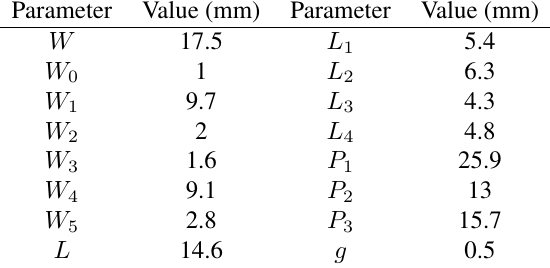
Table 1: Dimensions of the proposed ACS-fed tri-band an- tenna (all dimensions in mm) Parameter